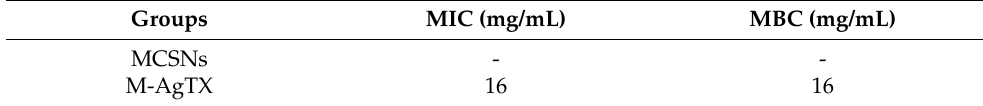
Table 2. MIC and MBC values of MCSNs and M-AgTX extracts against E. faecalis . Groups MIC (mg/mL) MBC (mg/mL) MCSNs -